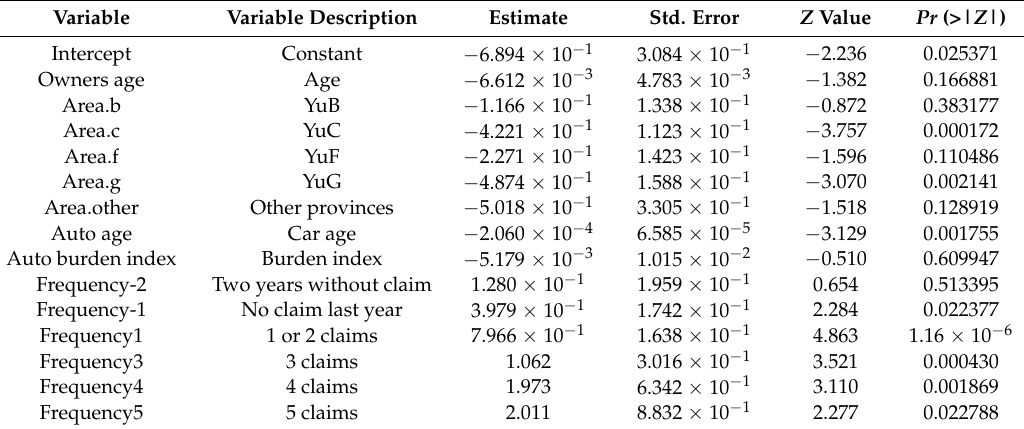
Table 8. Results of the Logistic regression model considering the auto burden